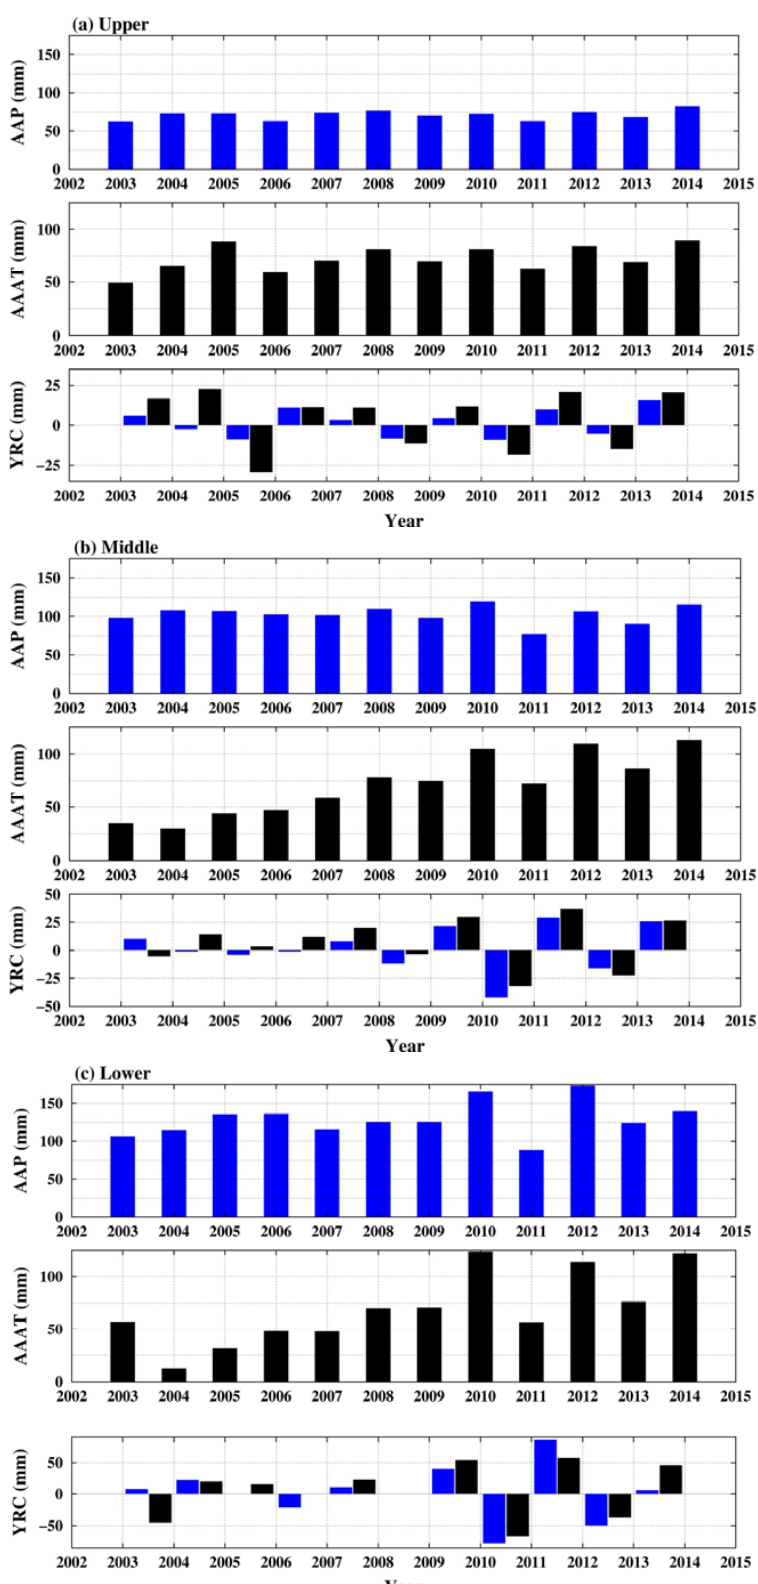
Figure 4. Annual Average Precipitation (AAP), Adjusted Annual Average TTWS (AAAT), and yearly relative change (YRC) of the AAP and AAAT in the ( a ) upper, ( b ) middle, and ( c ) lower sub ‐ basins of the YRB from 2003 to 2014.